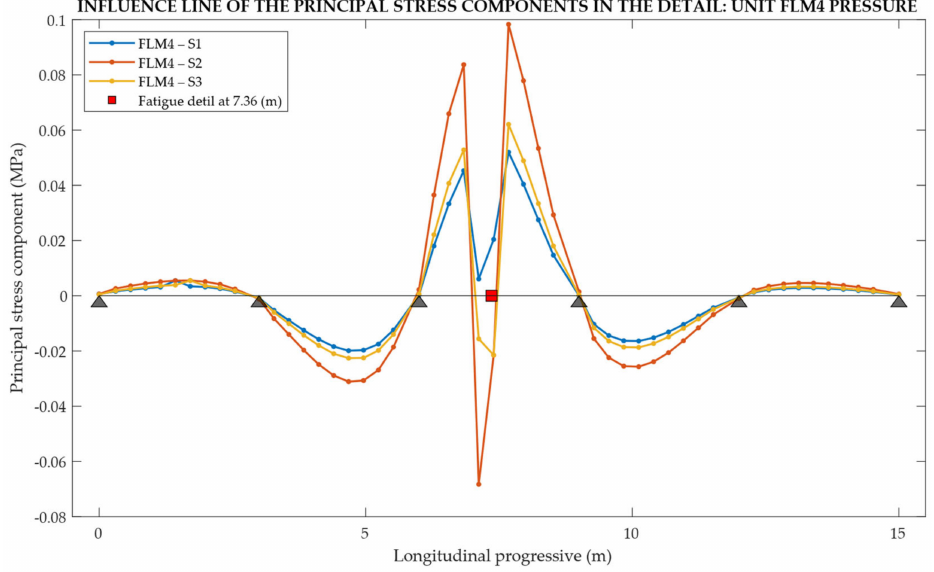
Figure 19. Principal stress components influence line for a fatigue detail at 7.36 m, exported from MIDAS GEN ®